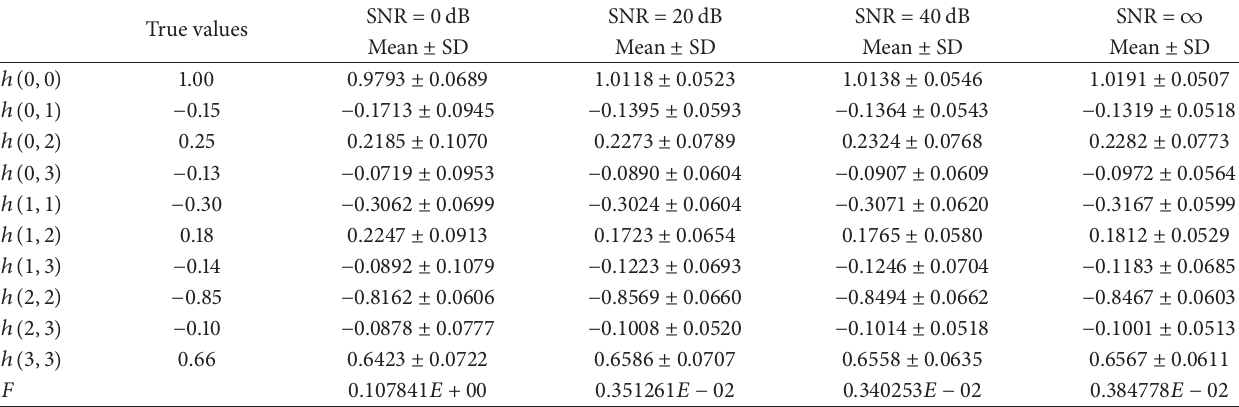
Table 3: Identified results [E2: full element ℎ(𝑖, 𝑗) ].